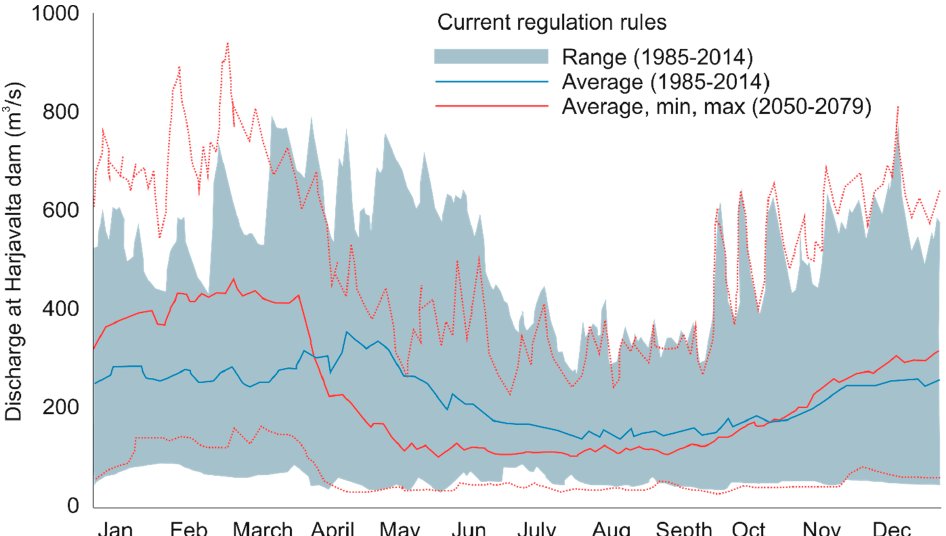
Figure 3. The effect of climate change on the discharge at the Harjavalta dam, shown by comparing the range and average discharge of the control period (1985–2014) with the expected future (2050–2079, average climate change scenario) discharge, using the current regulation rules (CURR). The upper and lower red dotted lines represent the maximum and minimum discharge in the climate change period, respectively. Data were modeled in the study by Dubrovin et al. [51].